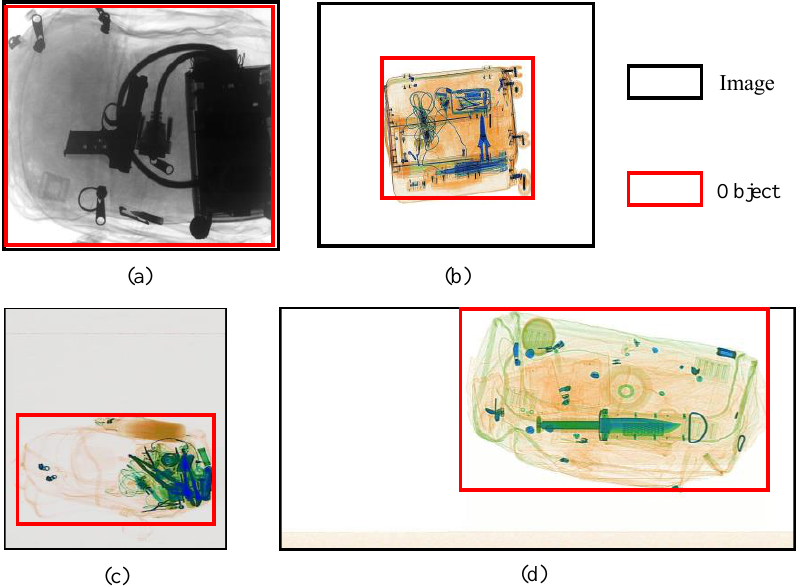
Figure 1. Examples of security X-ray images from popular public datasets: ( a ) GDXray [14], ( b ) OPIXray [13], ( c , d ) SIXray